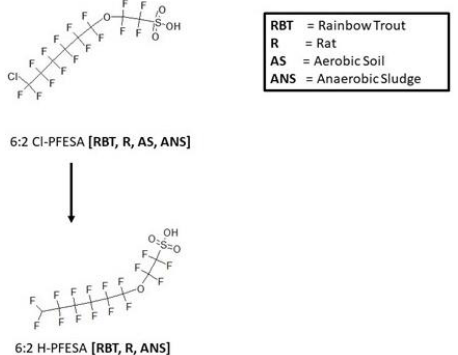
Figure 8. Metabolic map for 2-[(6-chloro-1,1,2,2,3,3,4,4,5,5,6,6-dodecafluorohexyl)oxy]-1,1,2,2-tetra- fluoroethanesulfonic acid (6:2 Cl-PFESA) as found in rainbow trout [20], rat [21], aerobic soil [22], and anaerobic sludge